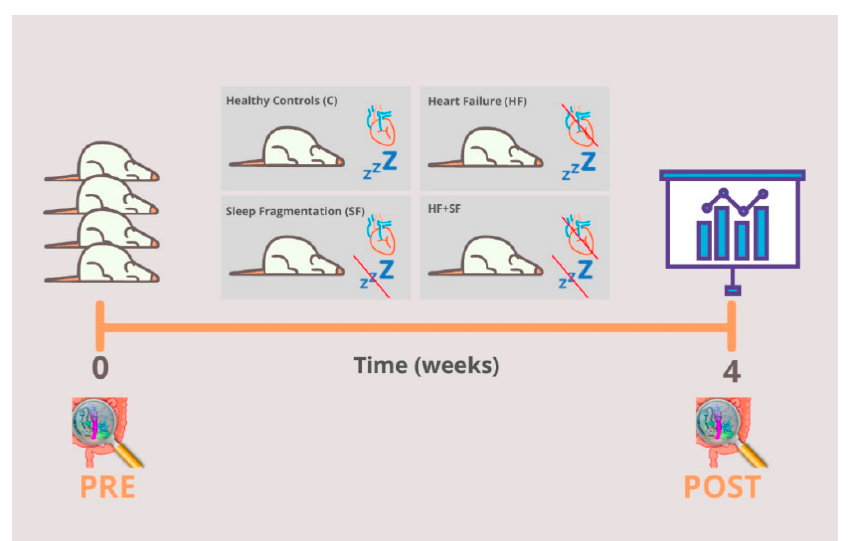
Figure 1. Experimental design of the study. Forty male mice ( n = 40) randomly distributed in four groups: Healthy controls (C), heart failure (HF), sleep fragmentation (SF) and the combination of both conditions (HF + SF). The microbiome profiles of fecal samples obtained from these models were studied before and after a 4-week induction of the conditions. At the end of the experiment two HF + SF mice died, ending up with a final sample size of 38 (N C = 10, N HF = 10, N SF = 10, N HF + SF = 8).